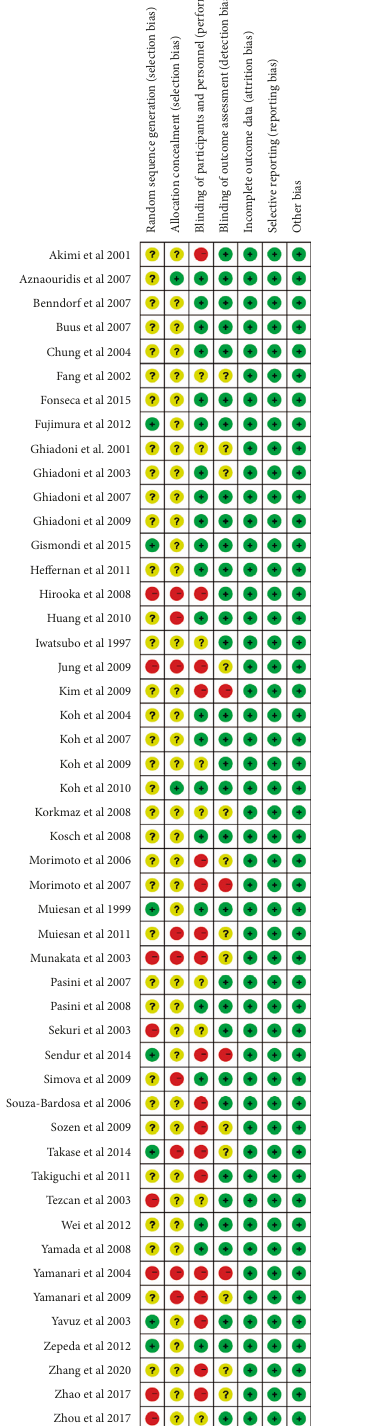
Figure 2: Methodological quality summary: review authors’ judgments about each methodological